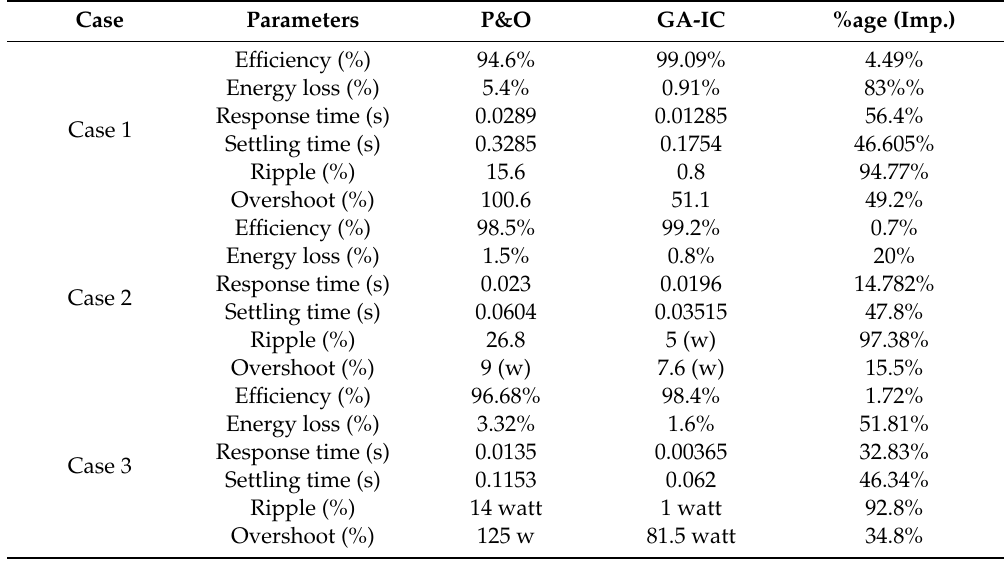
Table 7. Quantitative performance comparison of the GA-IC with